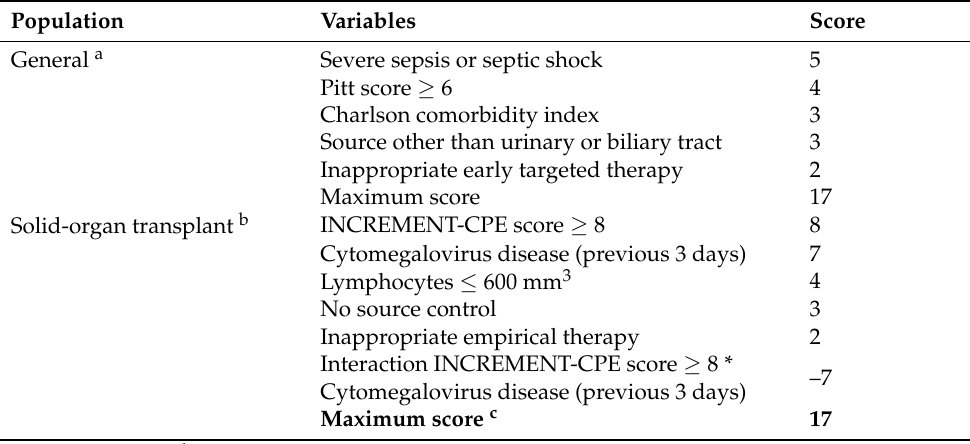
Table 4. INCREMENT-CPE score.